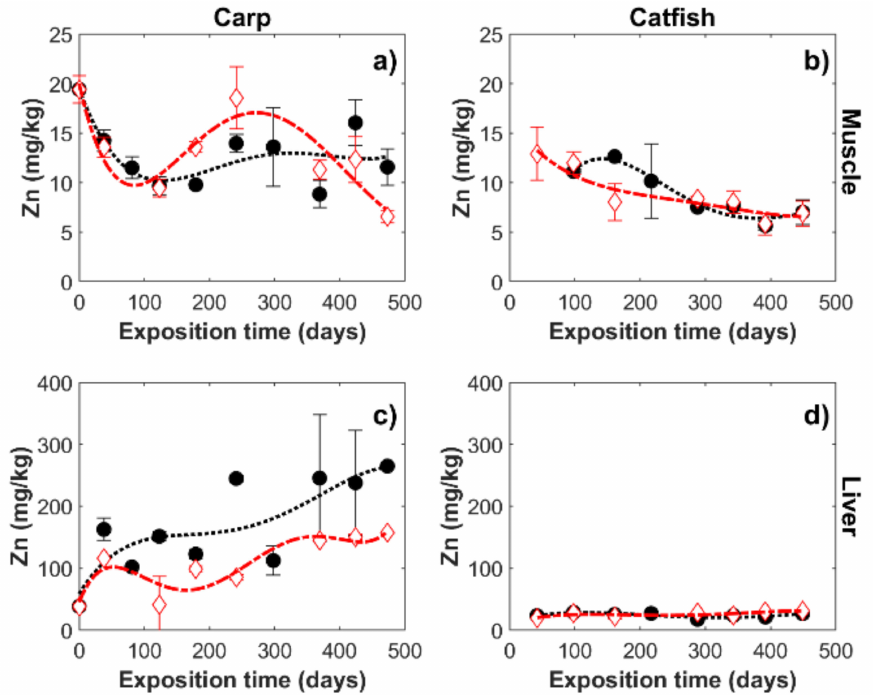
), in front of ( a ) muscle in (cid:51)